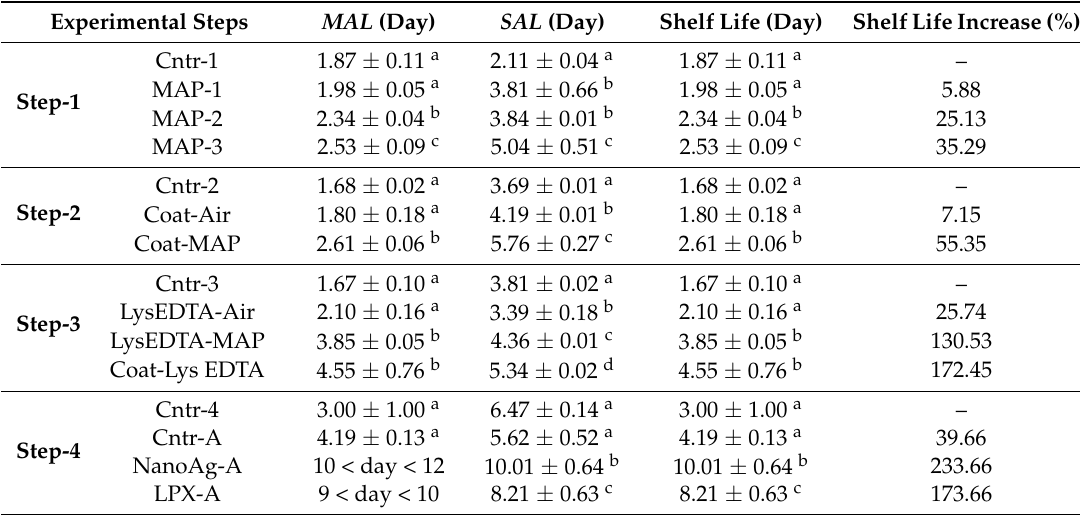
Table 2. Shelf life values (means ± sd) for each step calculated as the lowest value between MAL and SAL . The shelf life increase (%) compared to the control was also